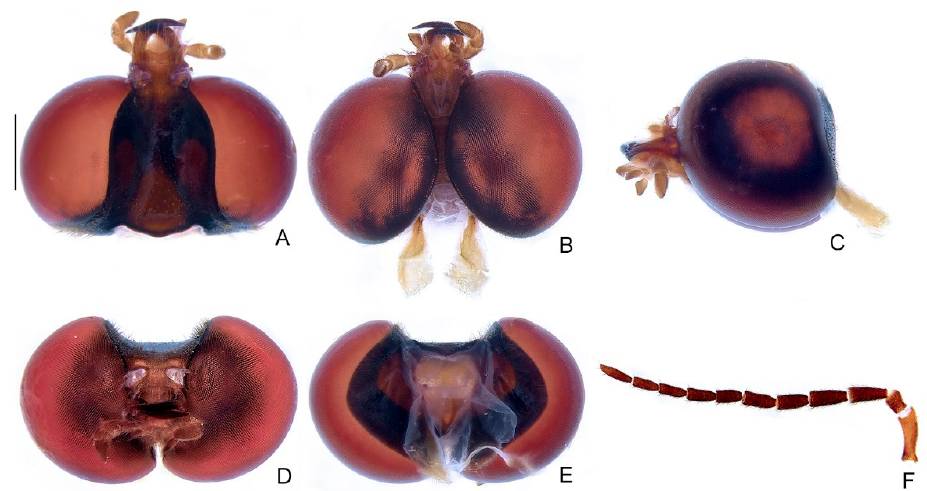
Figure 4. Zoiudo rosae sp. nov., head. ( A – E ) Head capsule: ( A ) dorsal, ( B ) ventral, ( C ) lateral, ( D ) frontal, ( E ) posterior. ( F ) Antenna, lateral. Scale bar: 1 mm.